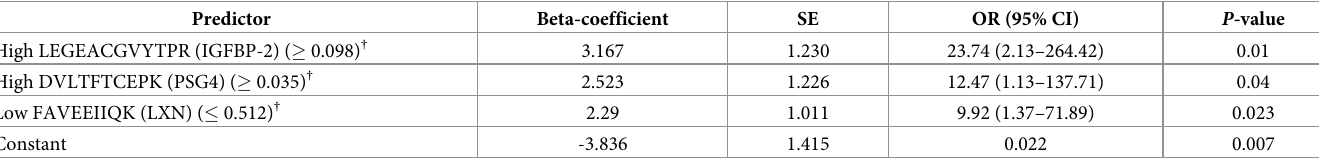
Table 4. Regression coefficients, ORs, and 95% CIs of the best protein panel � for predicting spontaneous preterm delivery (SPTD) at < 33 weeks of gestation.